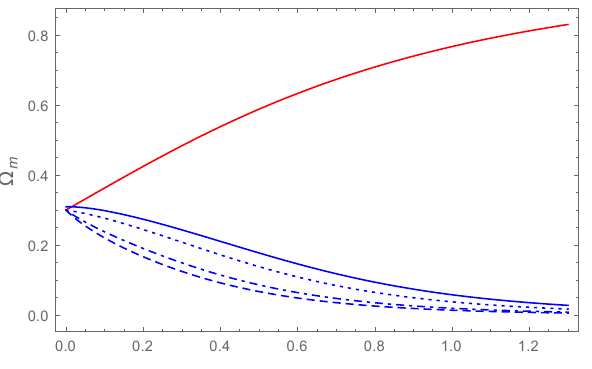
Figure 5. Variation of the dimensionless matter density, Ω m , as a function of z for K µν = + γ ( β ) T µν with different values of the parameters b 3 R 3 T curve), b 3 = 0.08 and g 3 = 0.097 (dotted curve), b 3 = 0.15 and g 3 = 0.30 (dashed curve), and b 3 = 0.21 and g 3 = 0.12 (dot-dashed curve). The evolution of the matter density in the standard Λ CDM model corresponds to the red solid